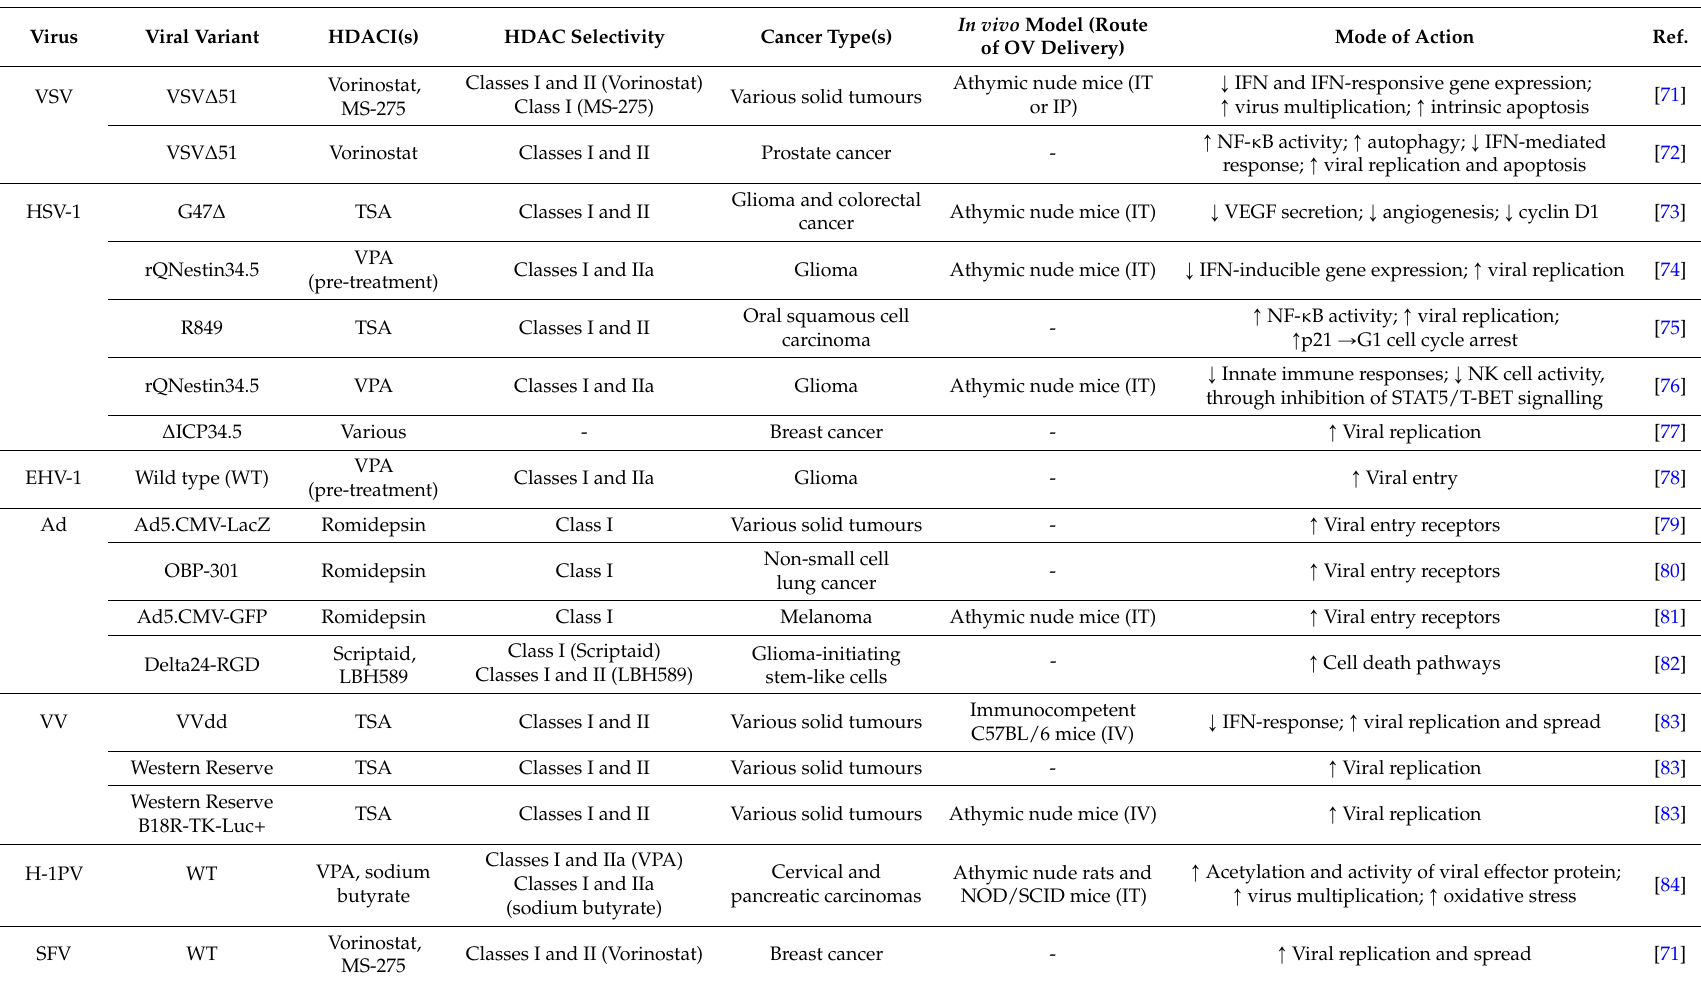
Table 1. OVs in combination with histone deacetylase (HDAC)